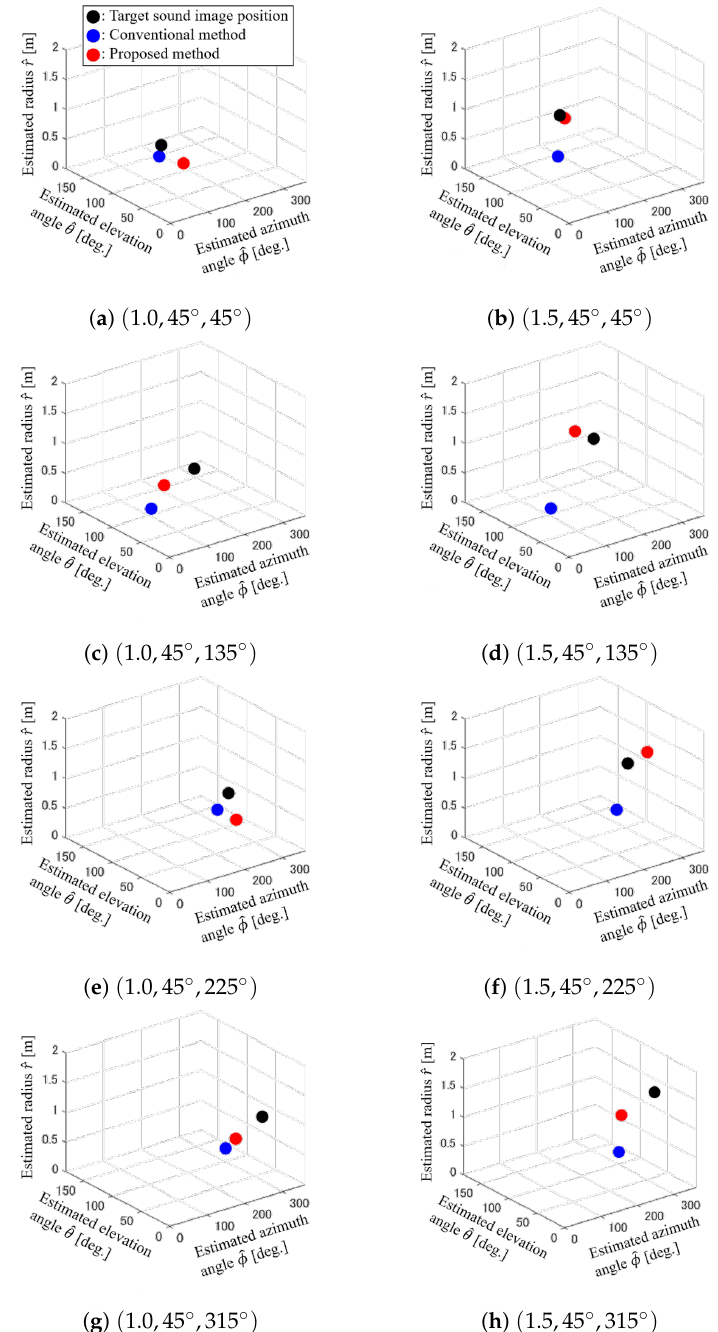
Figure 11. Estimated position of 3-D sound image ( ˆ r , ˆ θ , ˆ φ )